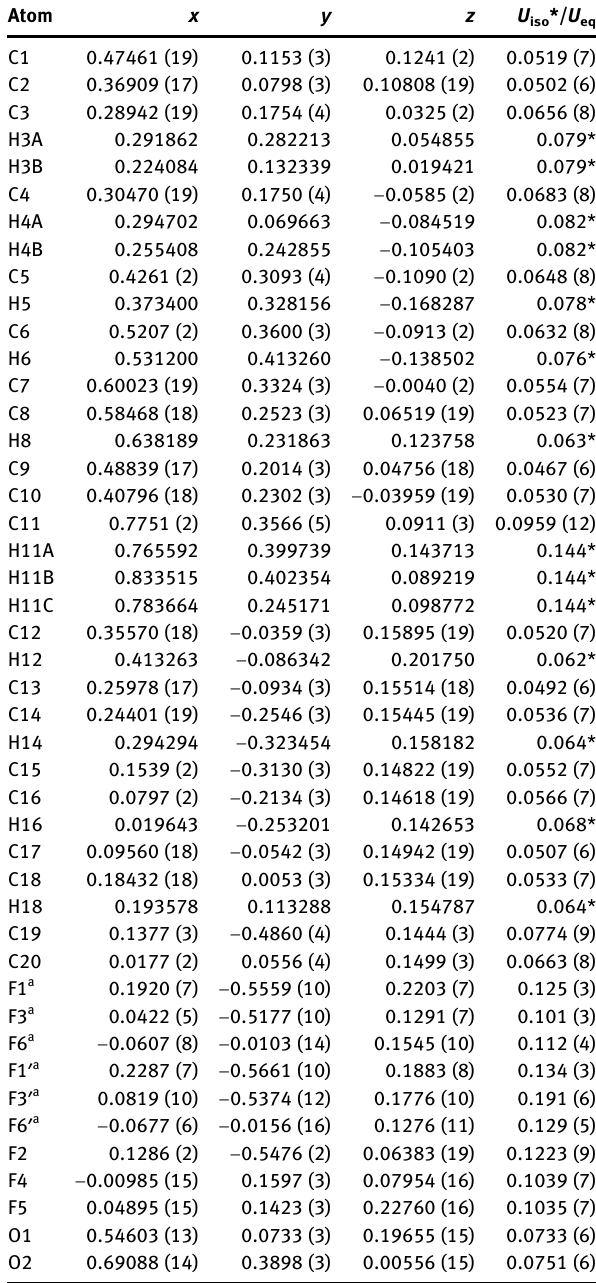
Table  : Fractional atomic coordinates and isotropic or equivalent isotropic displacement parameters (Å 